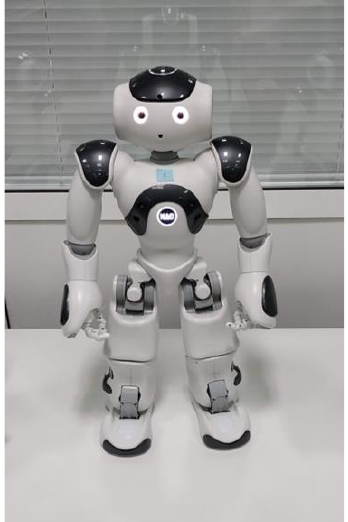
Figure 1. The humanoid social robot NAO.